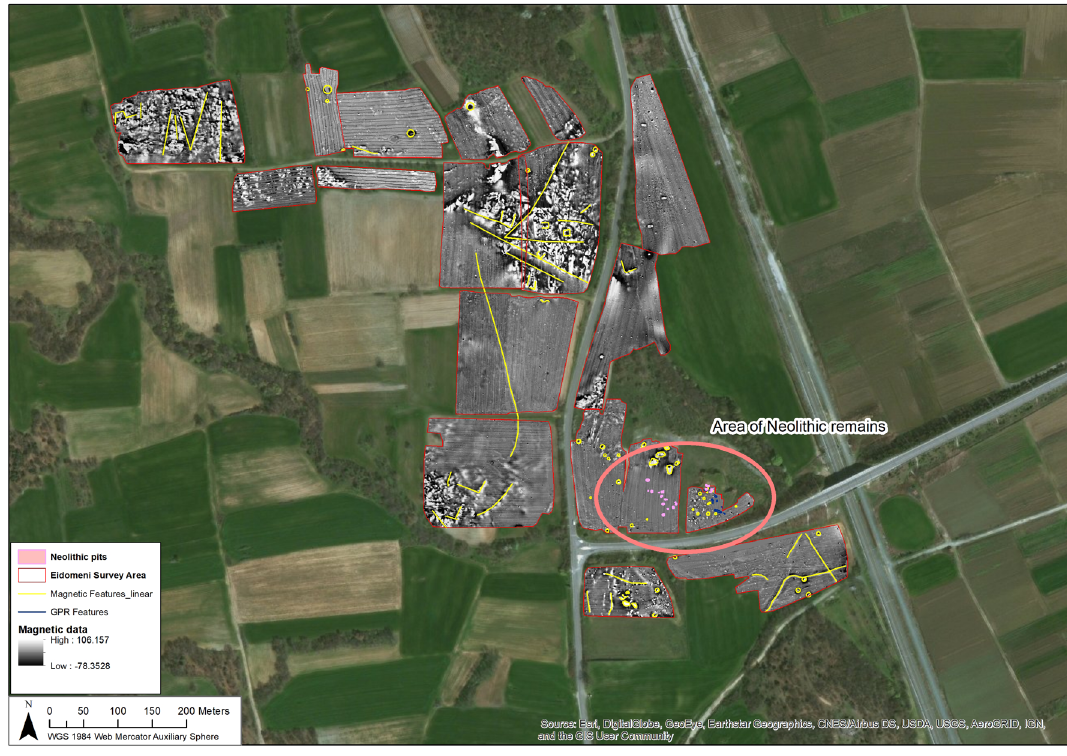
Figure 10. Further structural features detected by the geophysical investigation close to the Neolithic site (WGS 1984, WebMer- cator Auxiliary Sphere).